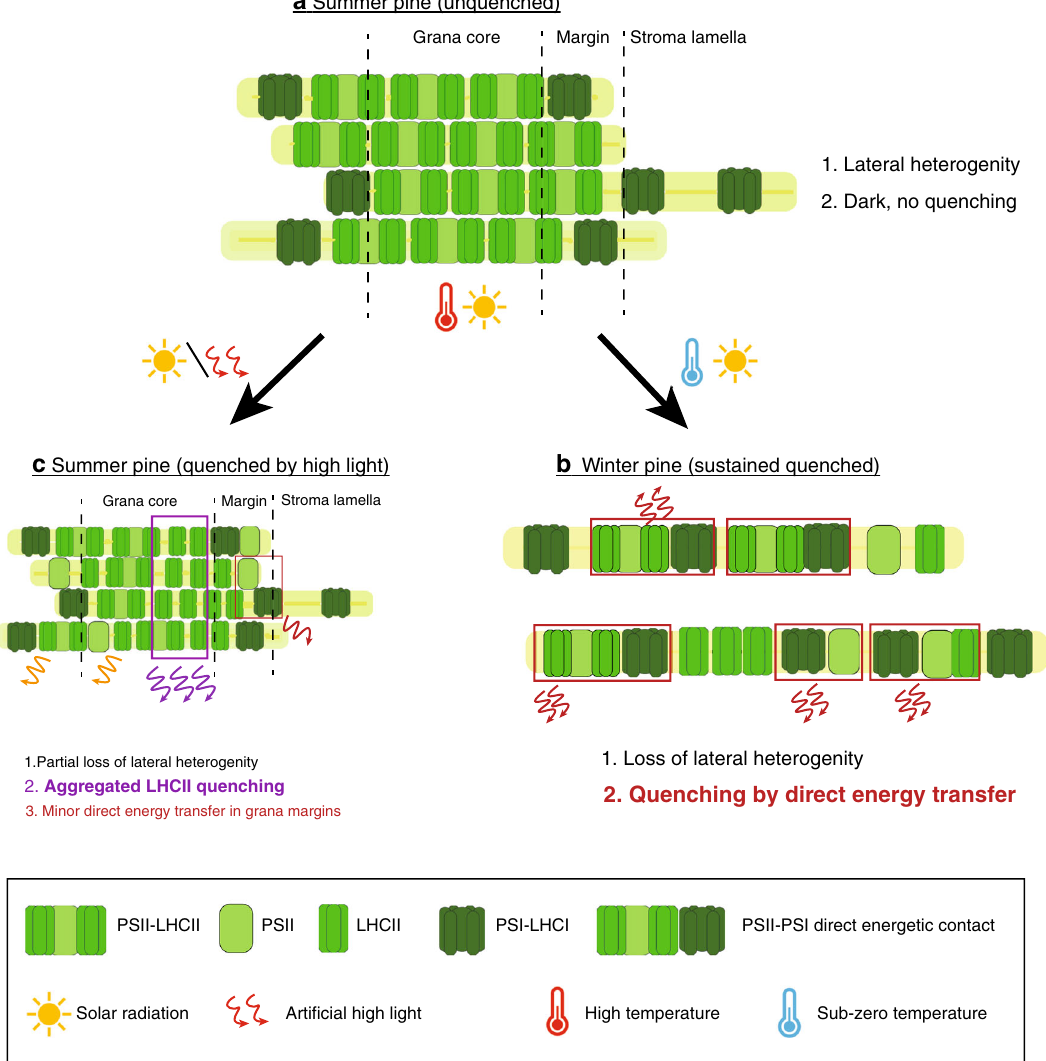
Fig. 6 Molecular model for acclimation of photosynthetic machinery under changing natural environmental conditions. Changes in Summer unquenched ( a ); Winter quenched ( b ); Summer quenched ( c ) in Scots pine. The larger text indicates the process is dominating under that condition. Text colors correspond to the legend colors of the fi